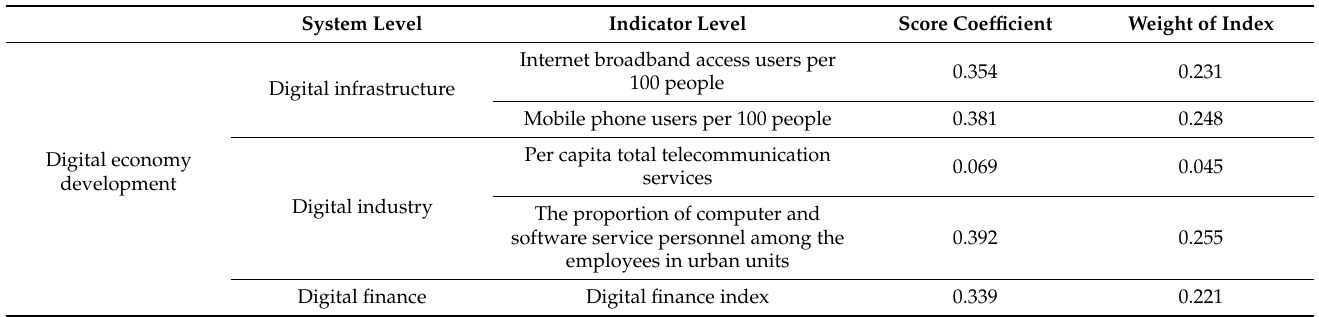
Table 1. Measurement system of the digital